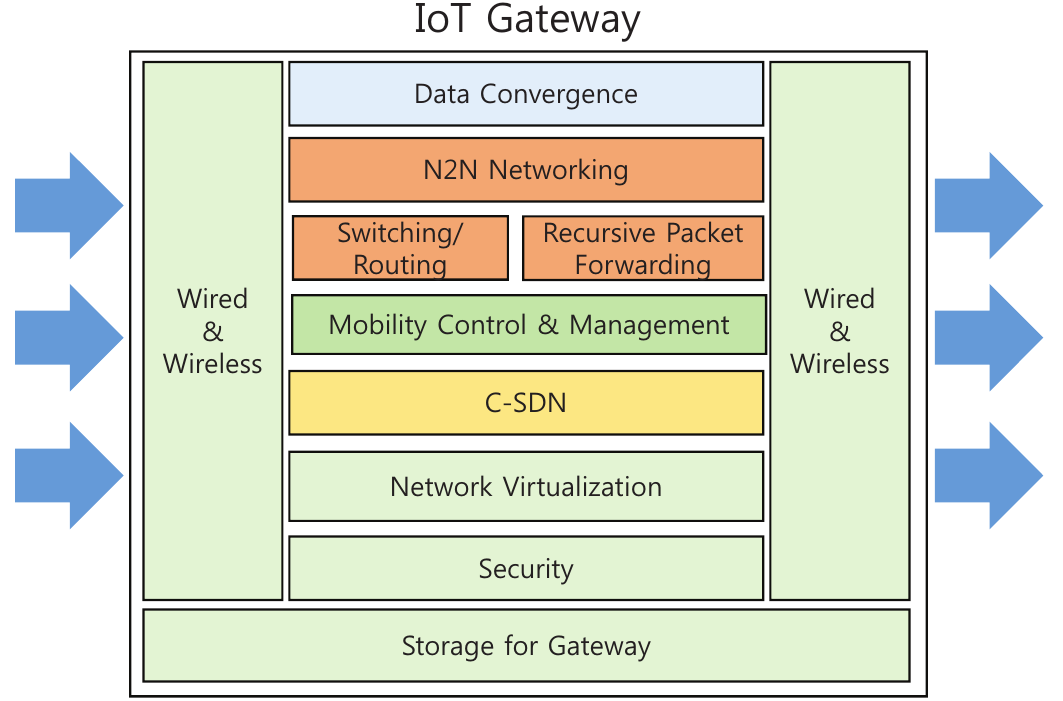
Figure 5. Overview of the IoT